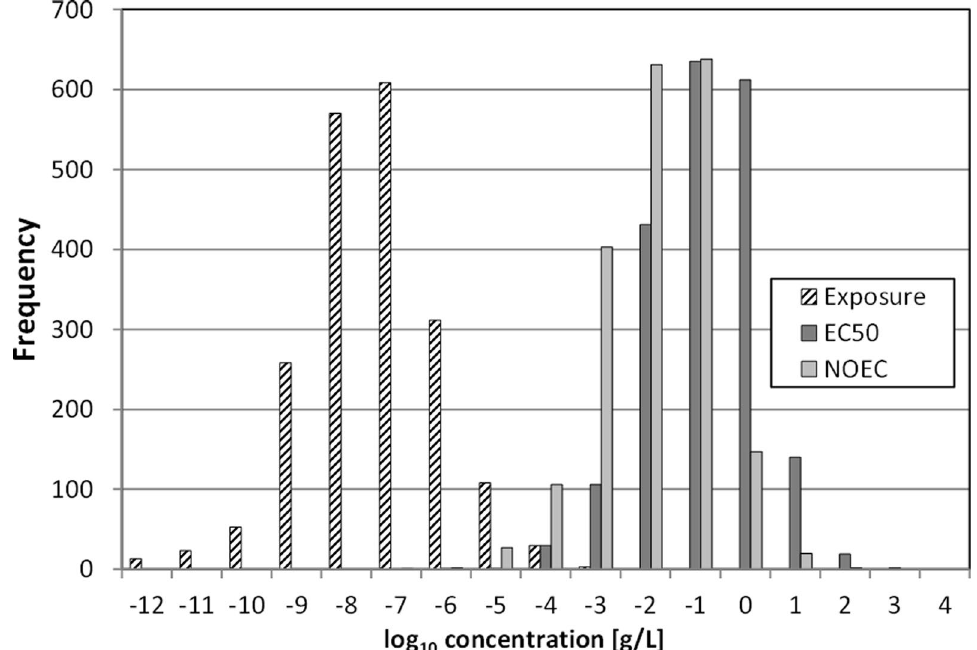
Fig. 5 Histograms of SimpleRisk-modeled median expected exposure concentrations in ‘typical EU fresh water’ and of median critical effect concentrations (average aquatic log-EC50-acute and log-NOEC-chronic (data from [21])) of the 1977 REACH-registered mono-constituent organic chemical substances in a ‘typical EU-water